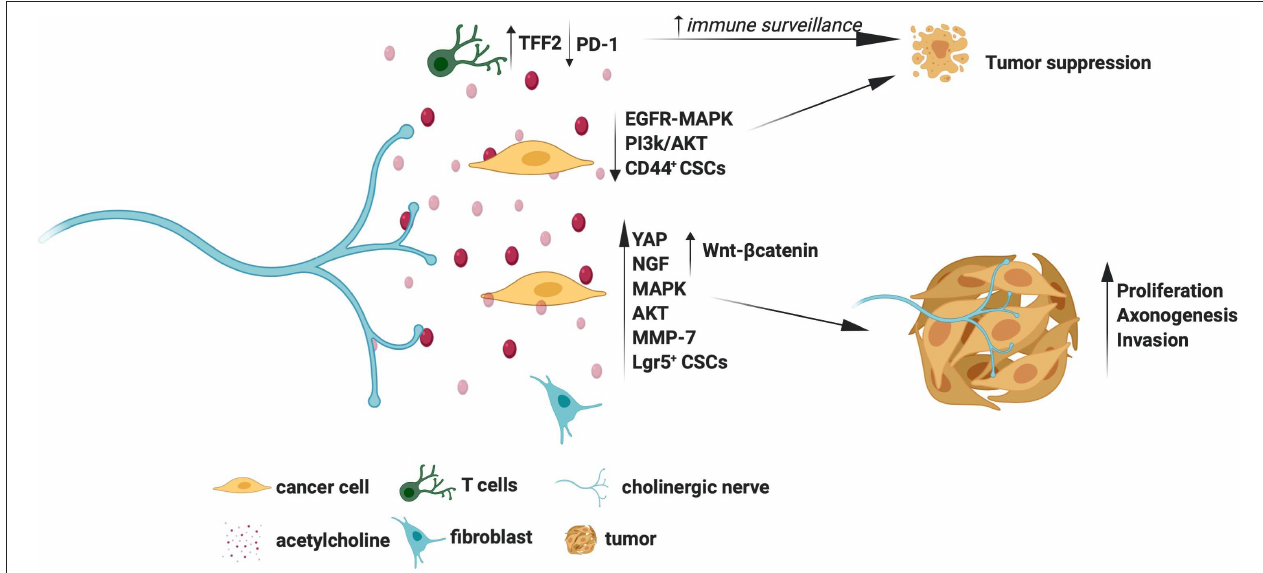
FIGURE 2 | Molecular mechanisms for the tumor promoting and suppressing actions of cholinergic